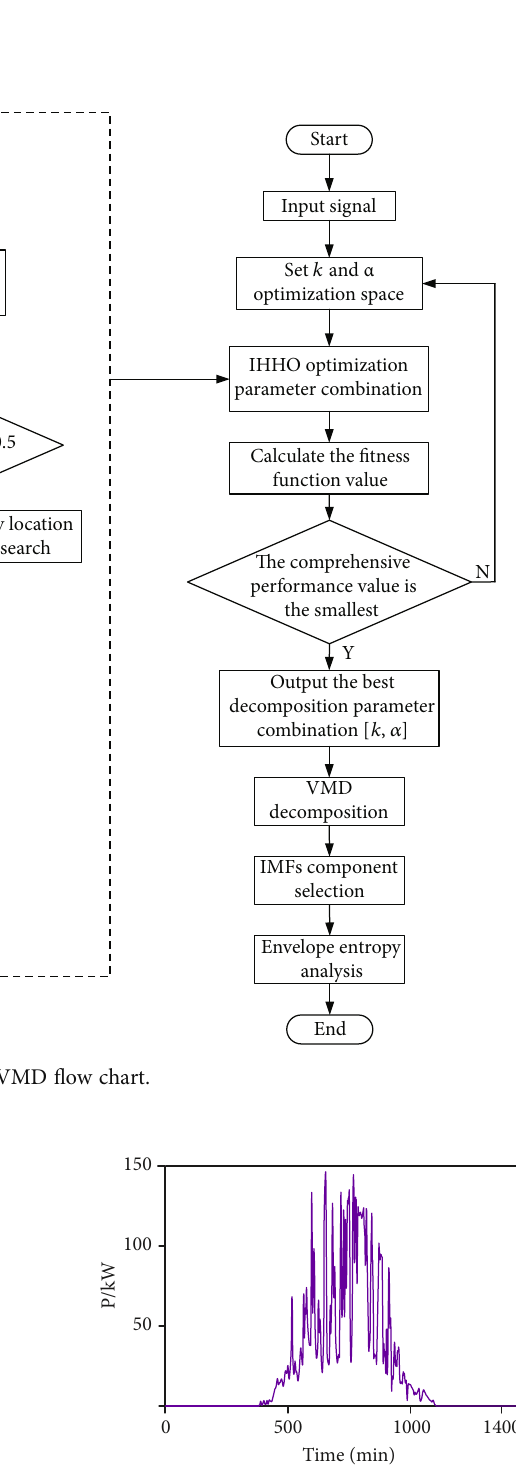
Figure 4: The original photovoltaic output curve of the